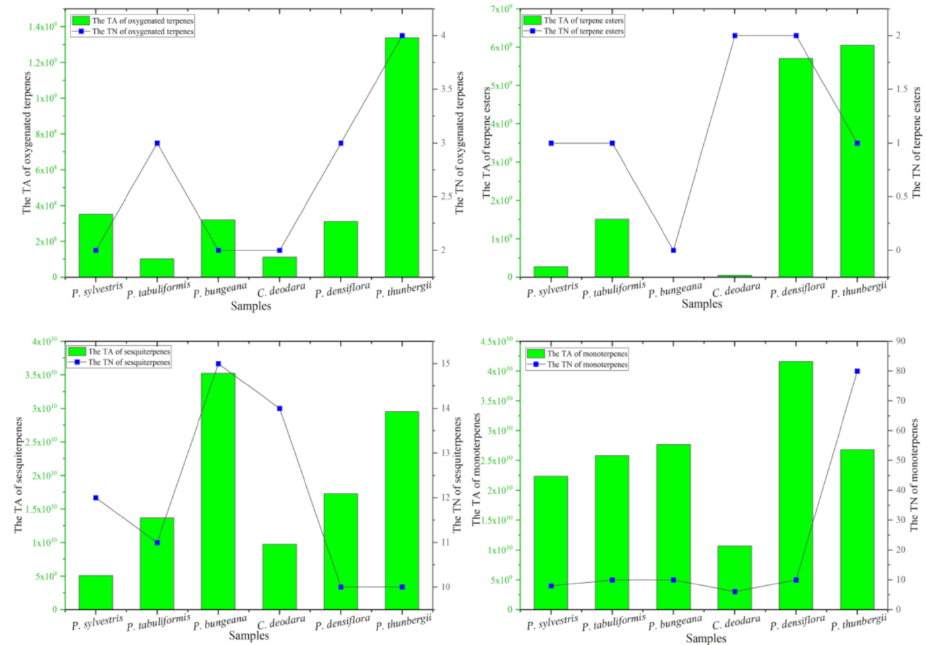
Figure 2. Comparison of monoterpenes, oxygenated terpenes, terpene esters, and sesquiterpenes in pine leaves. TA refers to total area. TN refers to total